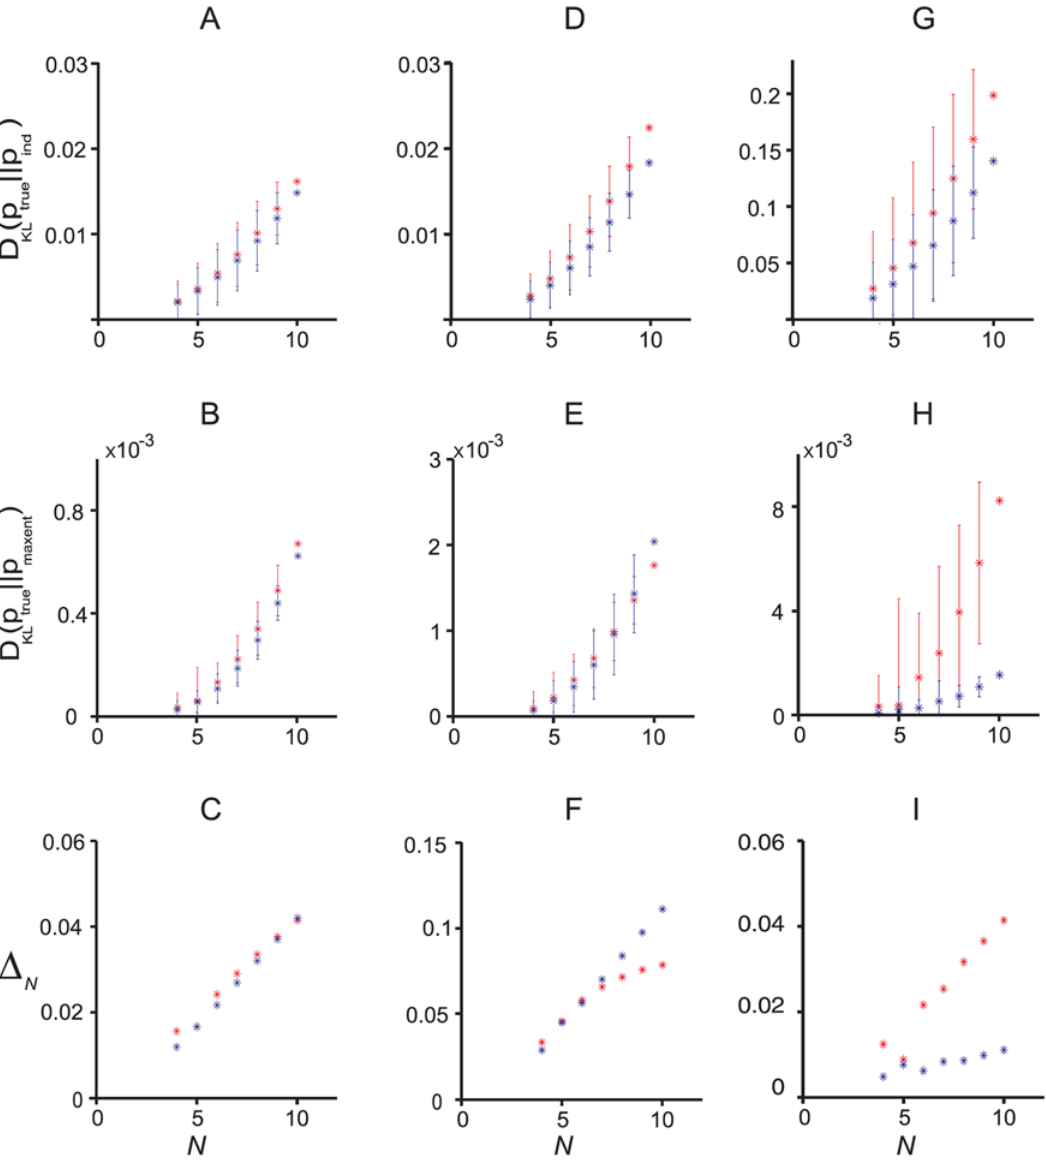
Figure 5. The N dependence of the KL divergences and the normalized distance measure, D N . Data was generated from a third order model, as explained in the section ‘‘Generating synthetic data’’ (Methods), and fit to pairwise maximum entropy models and independent models. All data points correspond to averages over marginalizations of the true distribution (see text for details). The red points were computed directly using p true k p ind ð Þ , D 0 p true k p pair (cid:1) (cid:2) , and D 0 , in rows 1, 2 and 3, respectively. The three Eqs. (1), (3) and (4); the blue points are the zeroth order estimates, D 0 N KL KL columns correspond to nd t ~ 0 : 024 , 0.029, and 0.037, from left to right. (A, B, C) ( nd t ~ 0 : 024 ). Predictions from the perturbative expansion are in good agreement with the measurements up to N ~ 10 , indicating that the data is in the perturbative regime. (D, E, F) ( nd t ~ 0 : 029 ). Predictions from the perturbative expansion are in good agreement with the measurements up to N ~ 7 , indicating that the data is only partially in the perturbative regime. (G, H, I) ( nd t ~ 0 : 037 ). Predictions from the perturbative expansion are not in good agreement with the measurements, even for small N , indicating that the data is outside the perturbative